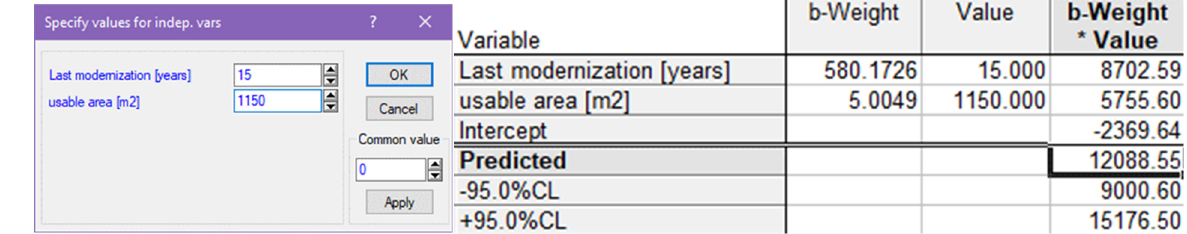
Figure 8. Specification of values for annual renovation cost prediction and annual renovation cost predictions for an exemplary building.